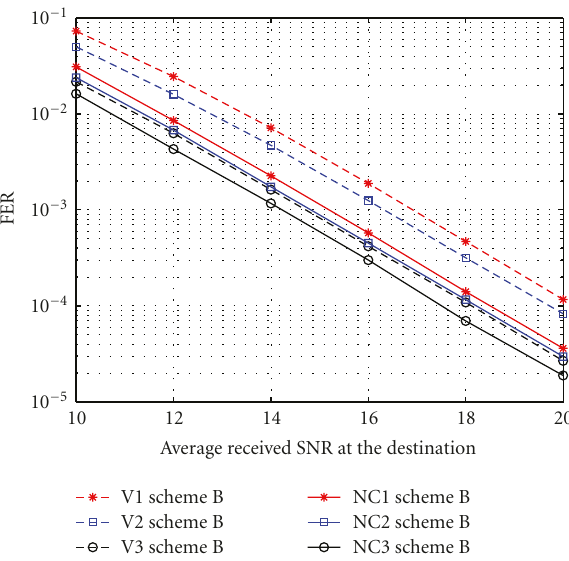
Figure 10: FER performances of QPSK codes for Scheme B (dSNR = 10dB).